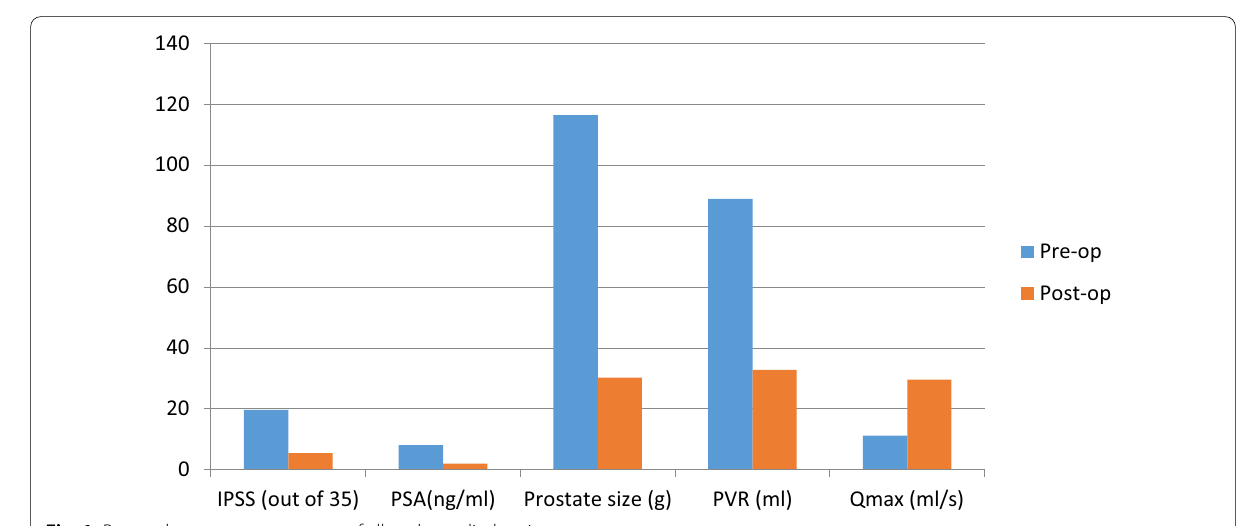
Fig. 1 Pre- and post-outcome scores of all understudied